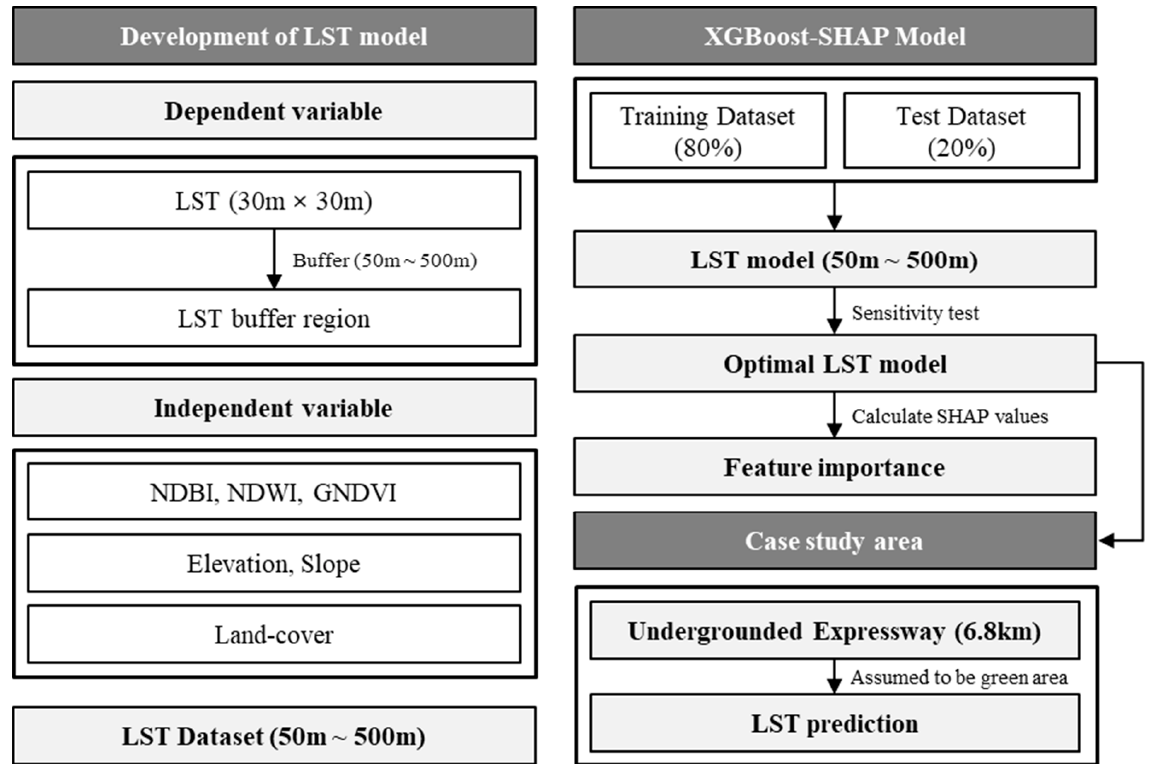
Figure 3. Research process.